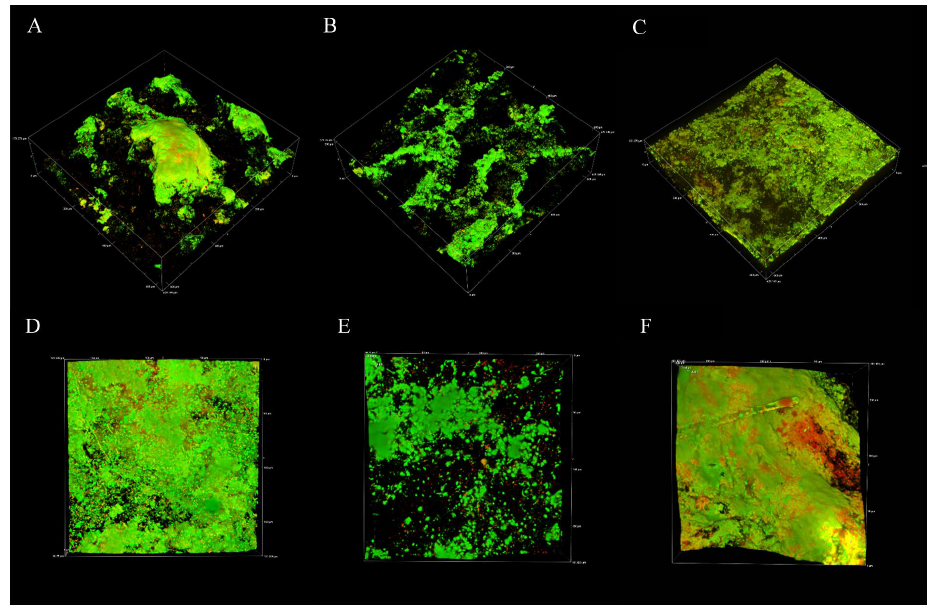
Figure 5. Live (green)and dead (red) staining of biofilms at 2, 4, and 6 weeks. Images were obtained with CLSM. ( A – C ) are larger micrographs (600 × 600 µ m). ( D – F ) represent the same surface captured using the Nyquist function of the Nikon Elements software for increased resolution.